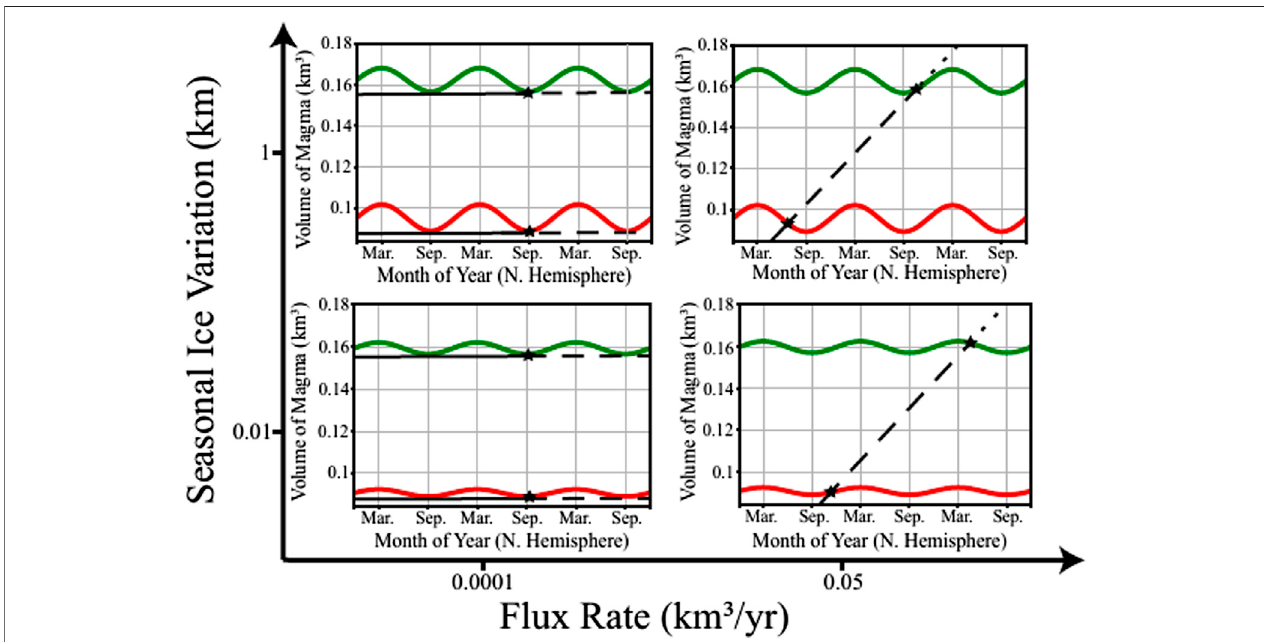
FIGURE7 | The relationship between fl ux rate and seasonality on the timing ofreservoirtensile failure. Each subplot compares theseasonallyvaryingtensile failure threshold of a3 km deep (depth to center, red line) and 5 km deep (depth to center, green line) spherical reservoir (radius = 0.62 km) against the continuous volume fl ux into the magma system (black line). The subplots are arranged within a set of larger axes, determining the amount of seasonal ice variation (10 m vs. 1 km) and the fl ux rate (0.0001 km 3 /yr vs. 0.05 km 3 /yr) into the system. In each case, tensile failure occurs at the point where the volume in the magma reservoir fi rst intersects the failure threshold (black stars). The solid, dashed, and dotted black lines indicate an example trajectory of the volume change before the initial rupture of the 3 km deep chamber, before the rupture of the 5 km chamber, and after the rupture of the 5 km chamber, respectively. When fl ux is low (left subplots), seasonal ice variations outpace the system ’ s long-term accumulation of magma volume, consistently causing failure when ice thickness reaches its minimum. On the other hand, high- fl ux systems (right subplots) can produce tensile failure in any season, although the distribution may be skewed depending on the magnitude of ice variation.